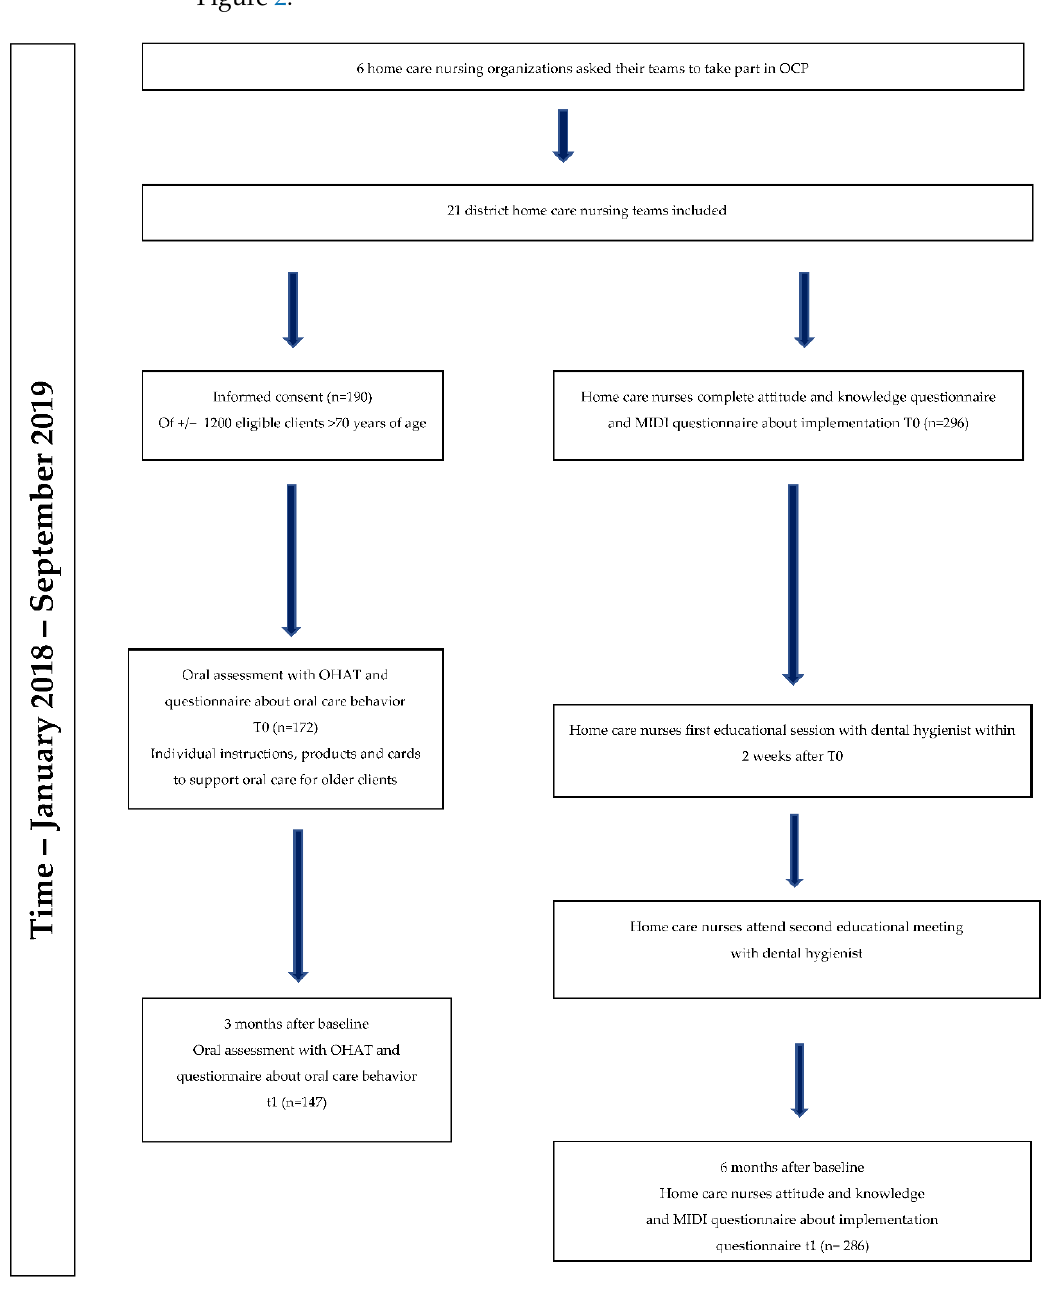
Figure 2. schematic overview of the OCP and measurements. Figure 2. Schematic overview of the OCP and measurements. Implementation Assessment